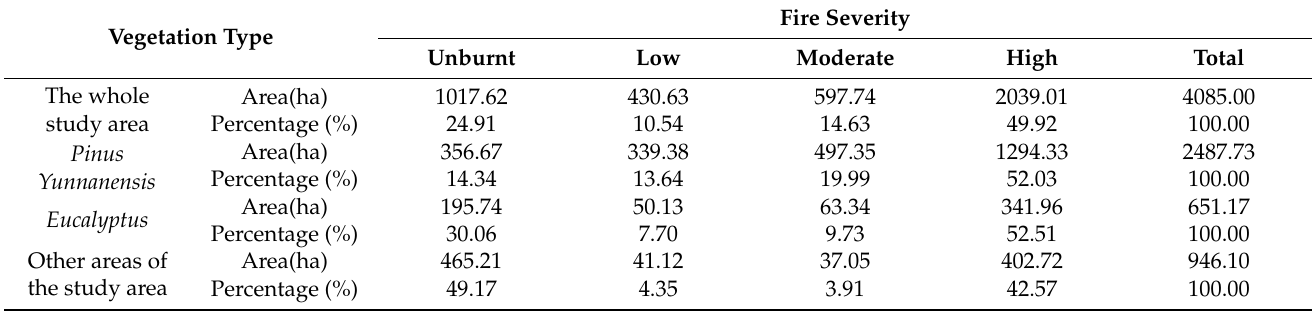
Figure 8. The distribution of land use types before the fire in the study area. The other tree species in the study area were mostly Cyclobalanopsis , aspen, and oak. The areas with higher altitudes are dominated by Pinus Yunnanensis , while the other vegetation was mainly distributed in the lower altitude areas in the west of the study area. Table 8. Area statistics of fire severity class across each vegetation type.